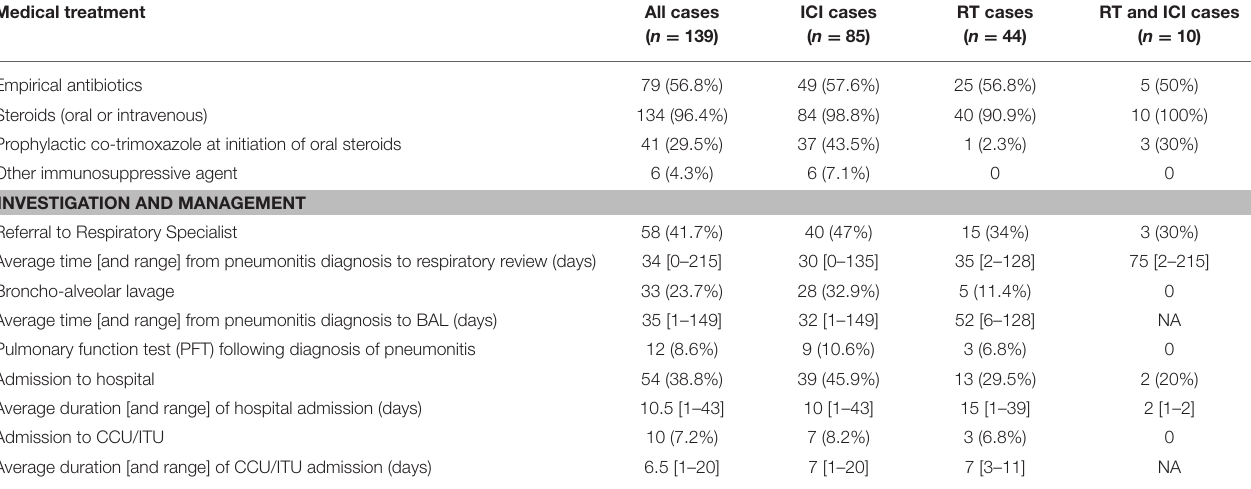
TABLE 2 | Medical treatment, investigation, and management for symptomatic